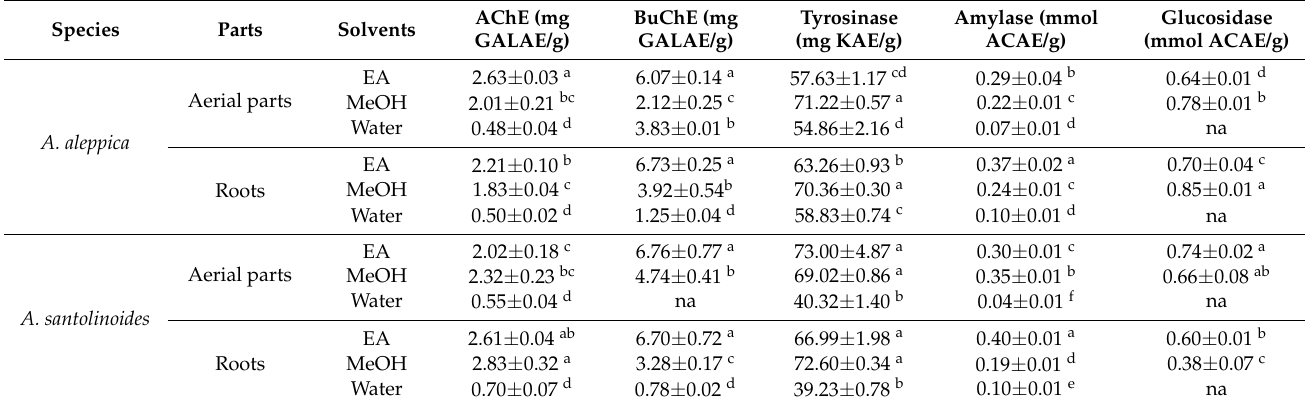
Table 4. Enzyme inhibitory effects of the tested extracts